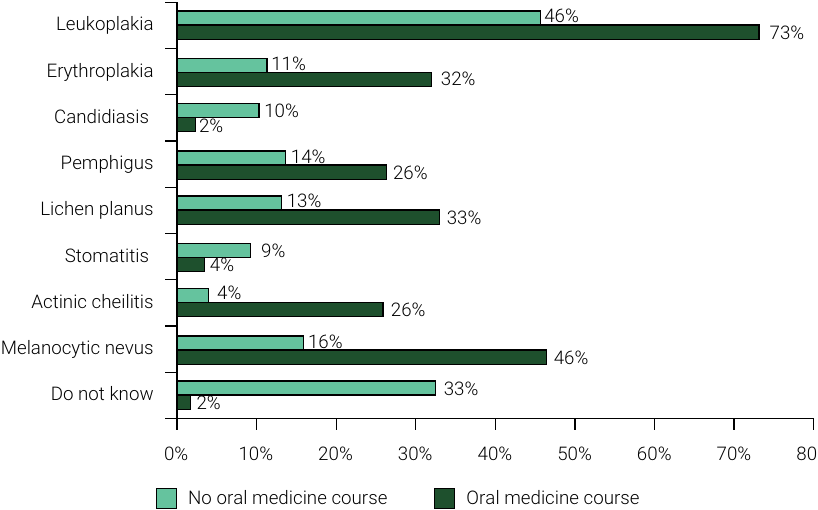
Figure 1. Risk factors and non-risk factors for oral cancer identified by students who had completed training in oral medicine and those who were yet to undergo training in this discipline. HPV: human papillomavirus